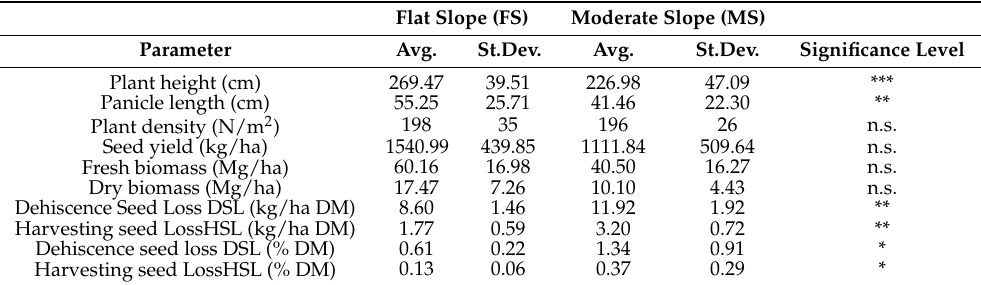
Table 4. Agronomic features of the crop and seed loss evaluation. “*” indicates statistically significant difference at p < 0.05; “**” indicates statistically significant difference at p < 0.01 and “***” indicates statistically significant difference at p <